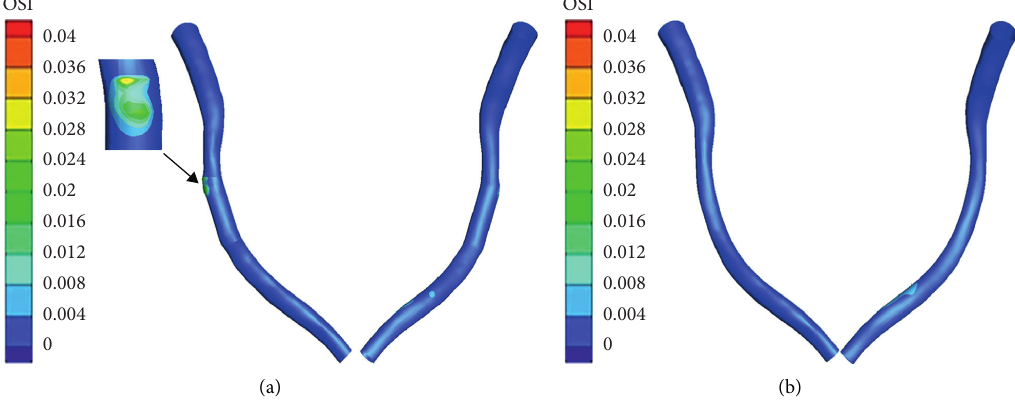
Figure 8: Counters of OSI: (a) straightening; (b) normal.